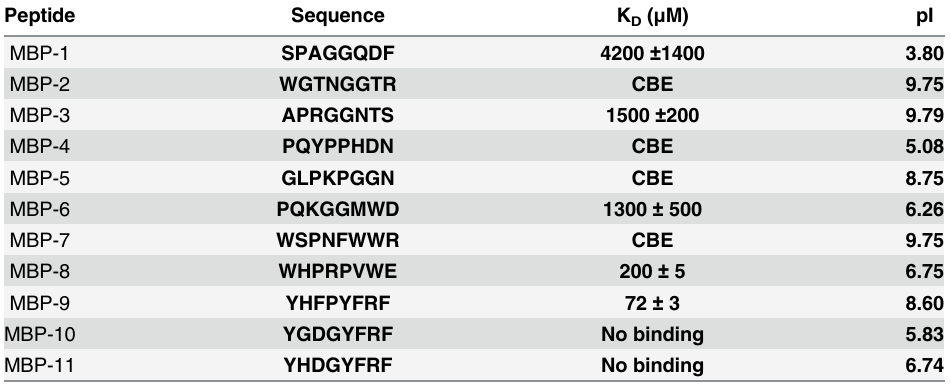
Table 2. k D (SPR determined) and pI values for the MBP peptides. CBE (Cannot be Estimated) is related to experiments in which signal variations were observed but K D estimation cannot be reached neither through kinetic nor saturation